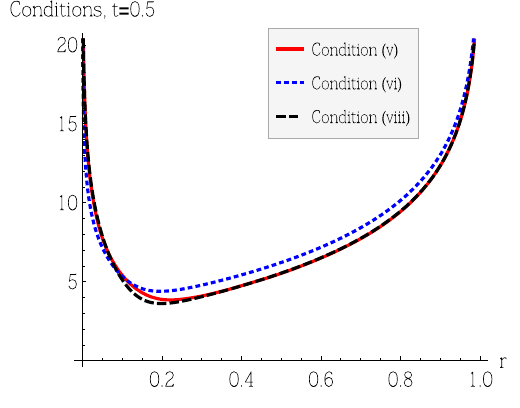
Fig. 17 Conditions (v), (vi), (viii) at t = 0 . 5